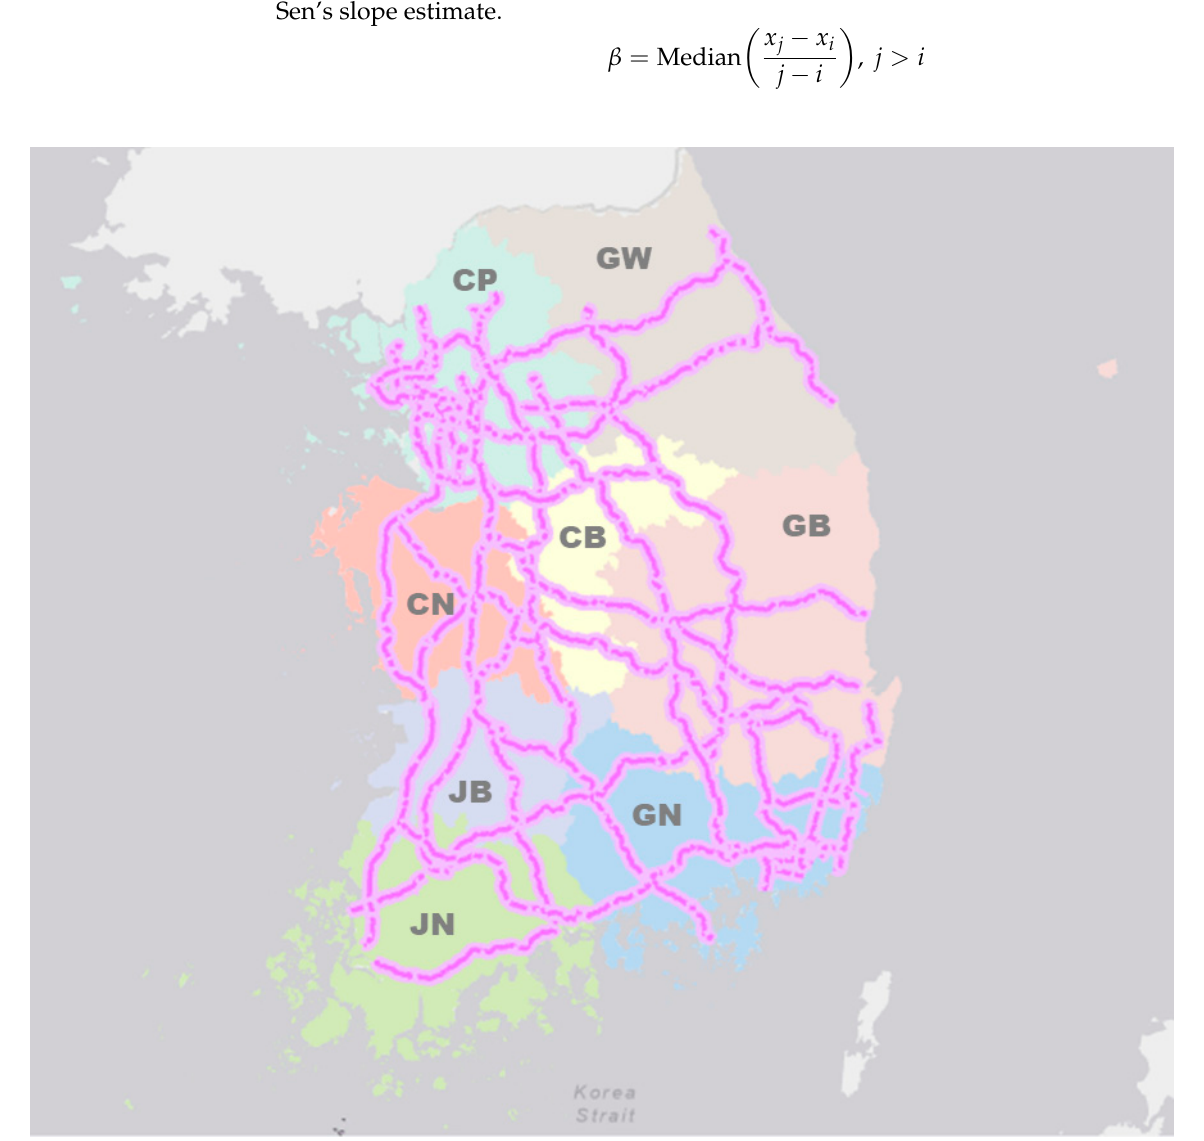
Figure 1. A map of the distribution of expressway and location of eight administrative districts in Korea where expressways are located. CP: Capital area, GW: Gangwon province, CN: Chungnam province, CB: Chungbuk province, JB: Jeonbuk province, GB: Gyeongbuk province, JN: Jeonnam province, GN: Gyeongnam